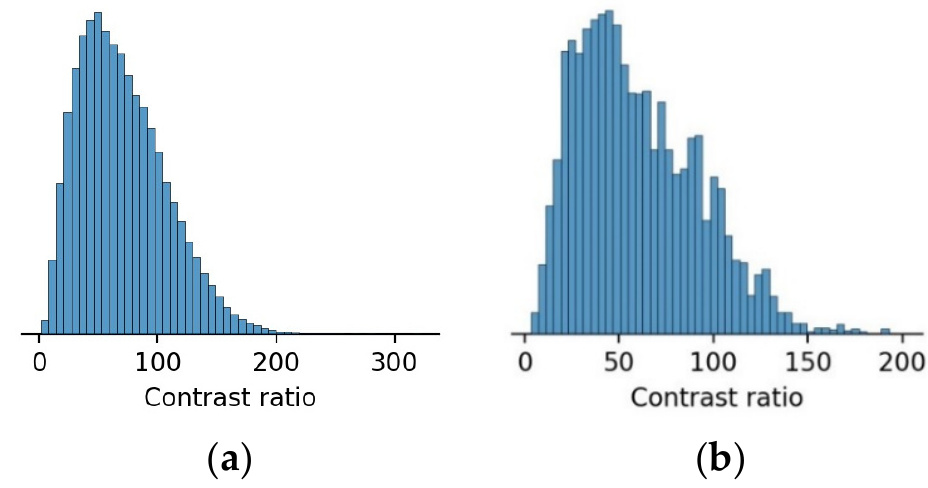
Figure 4. ( a ) The distribution map of contrast and quantity of targets in FLIR dataset; ( b ) the distribution map of contrast and quantity of targets in our dataset.